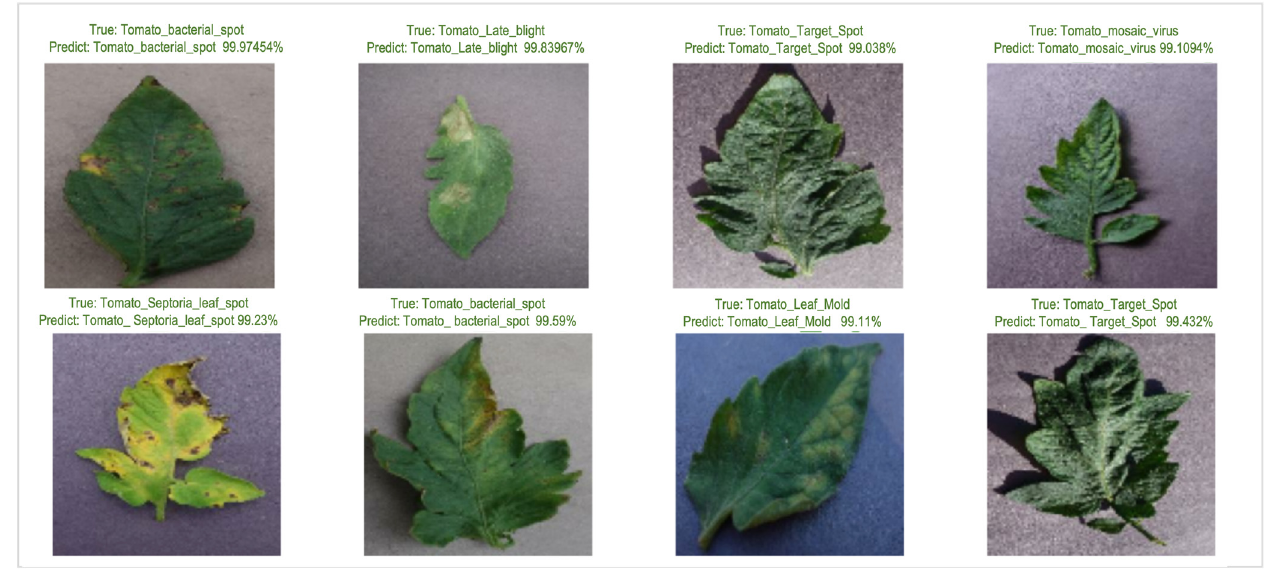
Figure 7. Sample predicted images using the proposed model.